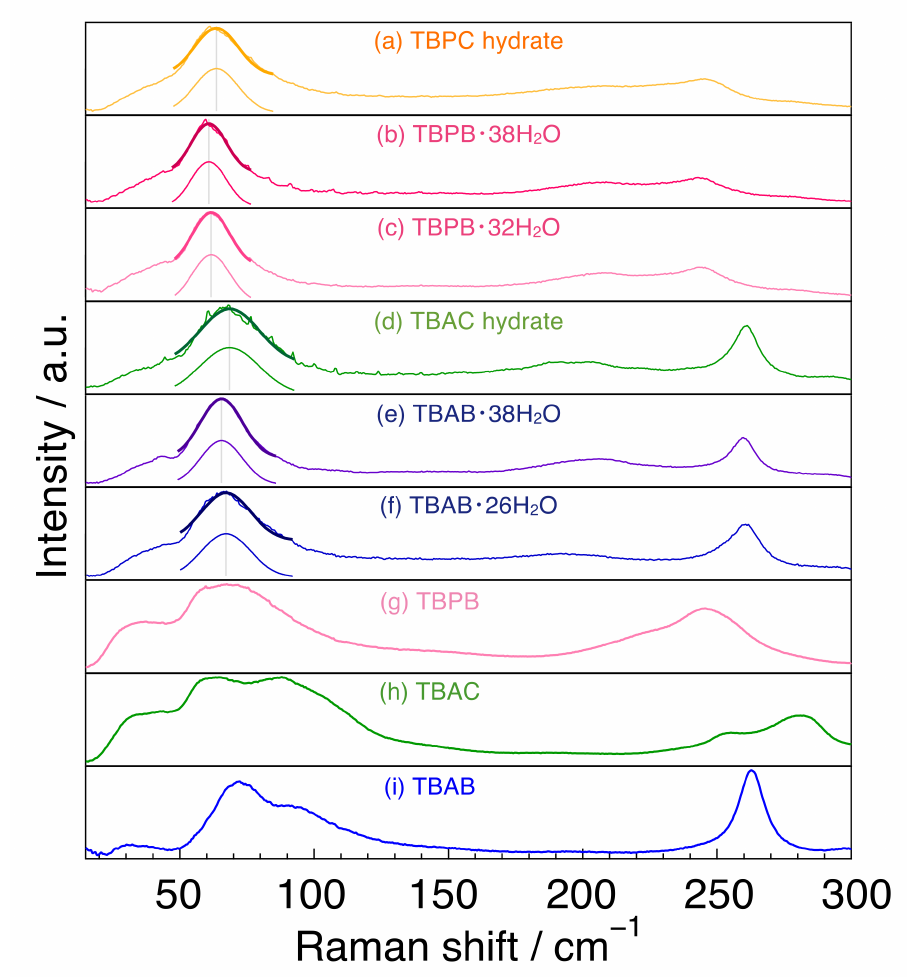
Figure 2. Raman spectra for tetrabutylammonium and tetrabutylphosphonium salts and their hydrates. (a) TBPC hydrate; (b) TBPB · 38H 2 O; (c) TBPB · 32H 2 O; (d) TBAC hydrate; (e) TBAB · 38H 2 O; (f) TBAB · 26H 2 O; (g) TBPB; (h) TBAC and (i) TBAB. The solid thick lines around 65 cm − 1 are single peak spectra simulated by